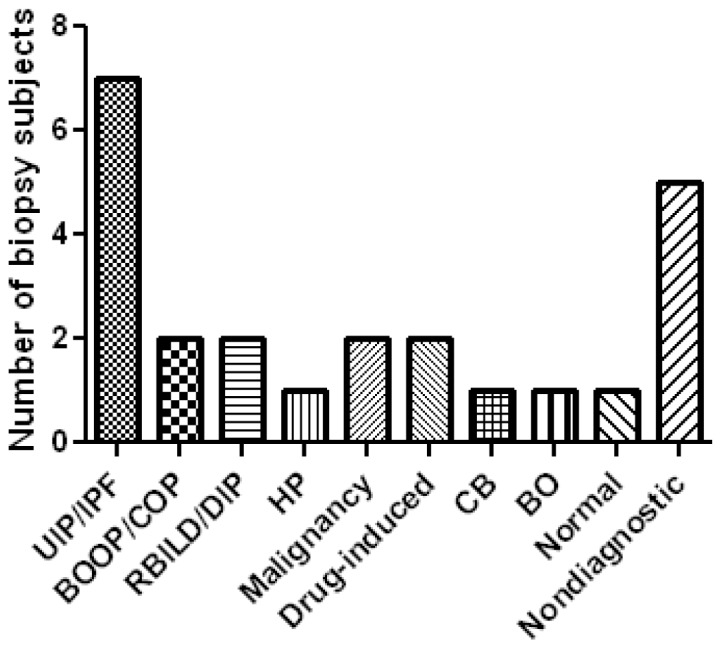
Distribution of diagnoses made by bronchoscopic cryobiopsy in 25 clinical subjects.Abbreviations: UIP/IPF, usual interstitial pneumonia/idiopathic pulmonary fibrosis; OP, organizing pneumonia; RBILD/DIP, respiratory bronchiolitis-interstitial lung disease/desquamative interstitial pneumonia; HP, hypersensitivity pneumonitis; CB, constrictive bronchiolitis.